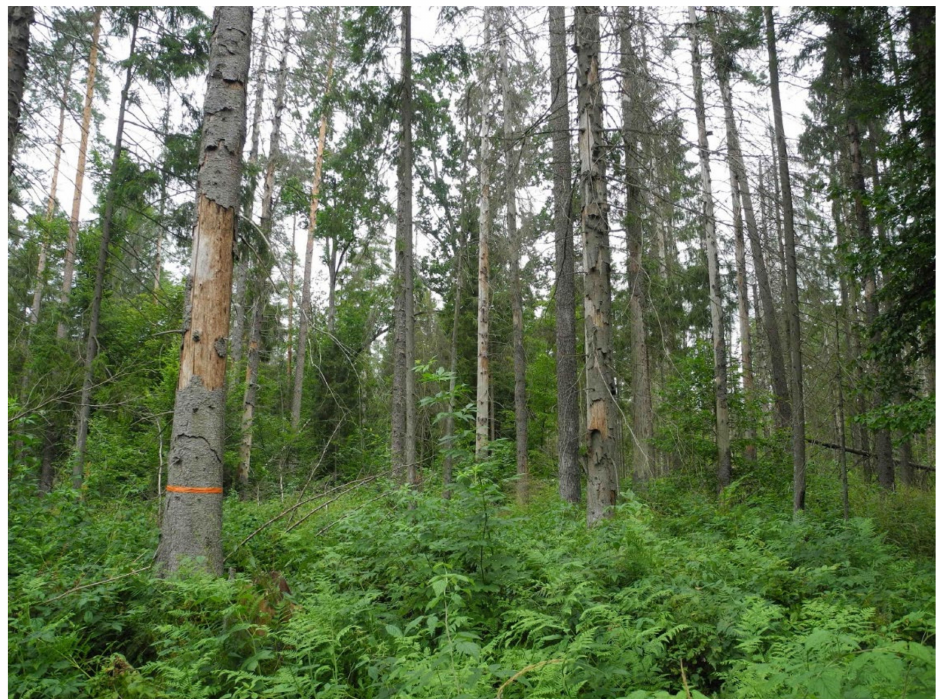
Figure 1. Mixed coniferous forest dominated by Norway spruce with dead trees as a result a bark beetle outbreak. On the left you can see the tree (marked with tape) in which a radio-tagged female barbastelle was found. There is also visible spruce undergrowth (in the background), which did not suffer from beetle infestation (photo A.